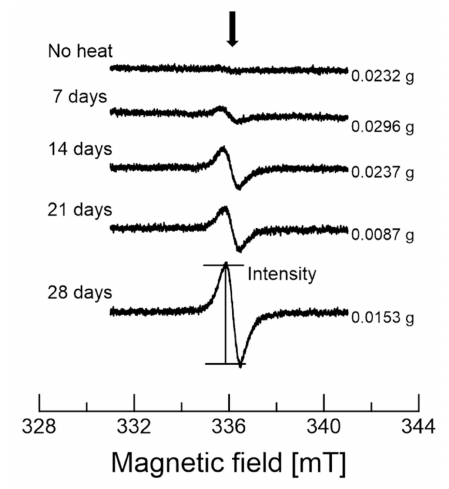
Figure 3. EPR spectra of the various garlic samples. The sample weights are indicated on the right-hand side of the image.